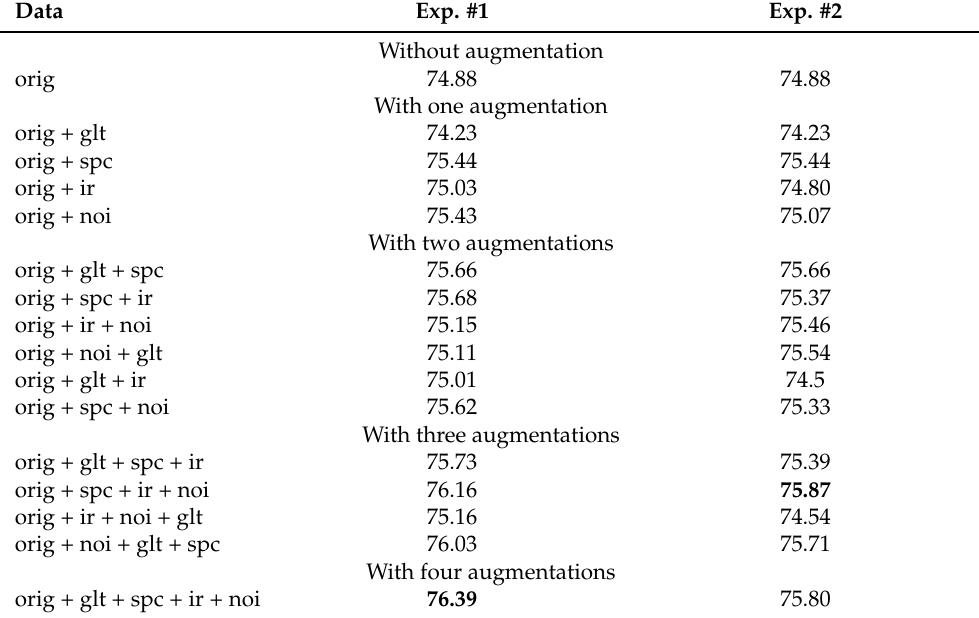
Table 5. Unweighted average recall (UAR, %) of SER with different data augmentation techniques on IEMOCAP . orig = original IEMOCAP dataset, glt = glottal source extraction, spc = speech cleaned, ir = impulse response, noi = noise addition. The highest scores for each experiment are in